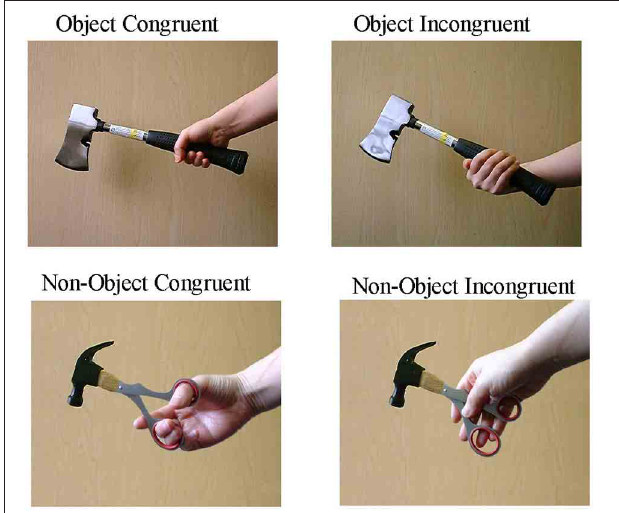
FIGURE 1 | Examples of the stimuli used in the experiment. Objects and non-objects were gripped congruently or incongruently.